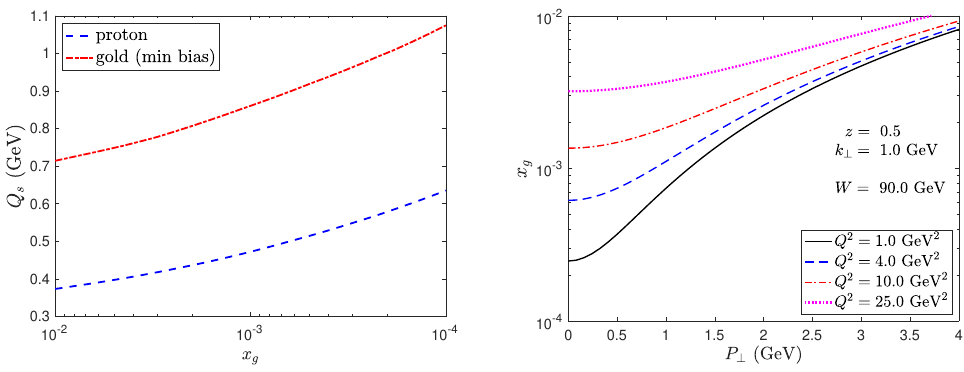
Figure 2 . Left: saturation scale Q s as a function of x g for proton, and gold at median impact parameter (proxy for minimum bias collision). Right: values of x g as a function of the kine- matic